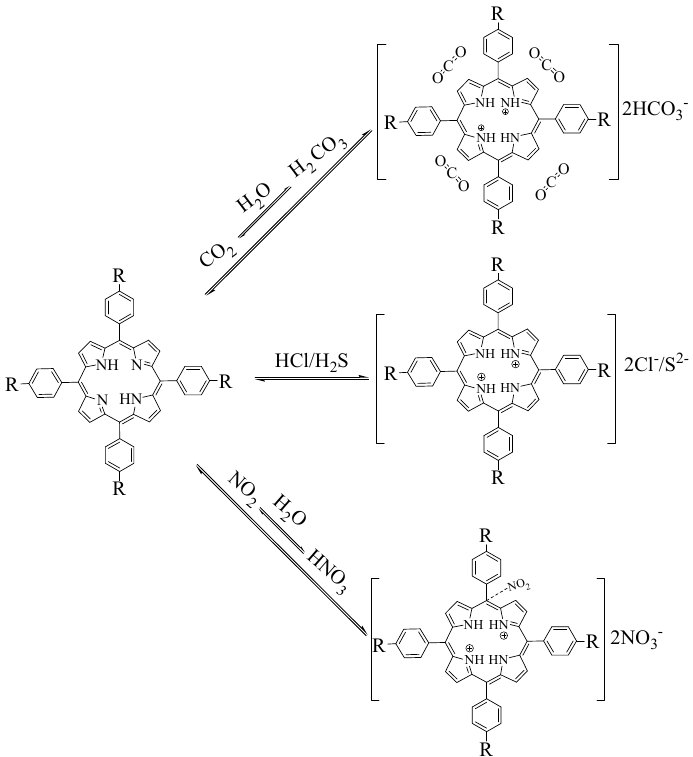
Figure 8. Interaction between porphyrins and analyte gases.